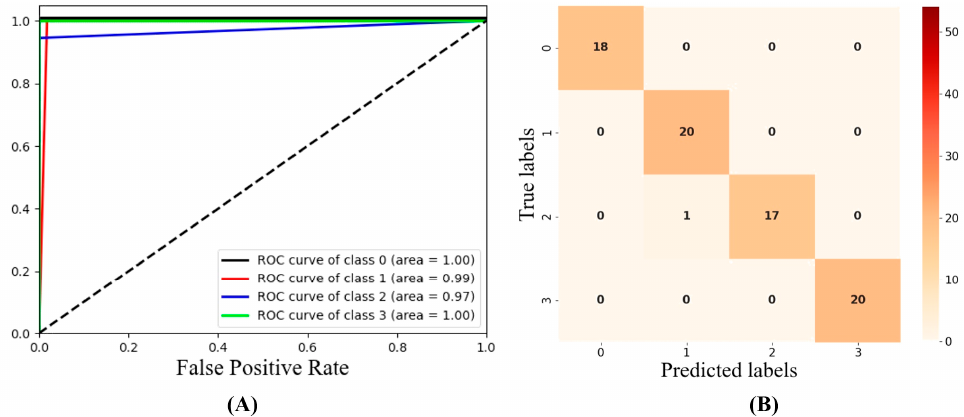
Figure 4. ROC curves ( A ) and confusion matrix ( B ) for optimal results with RF based on RGB and HSI images of EWs’ fusion features.